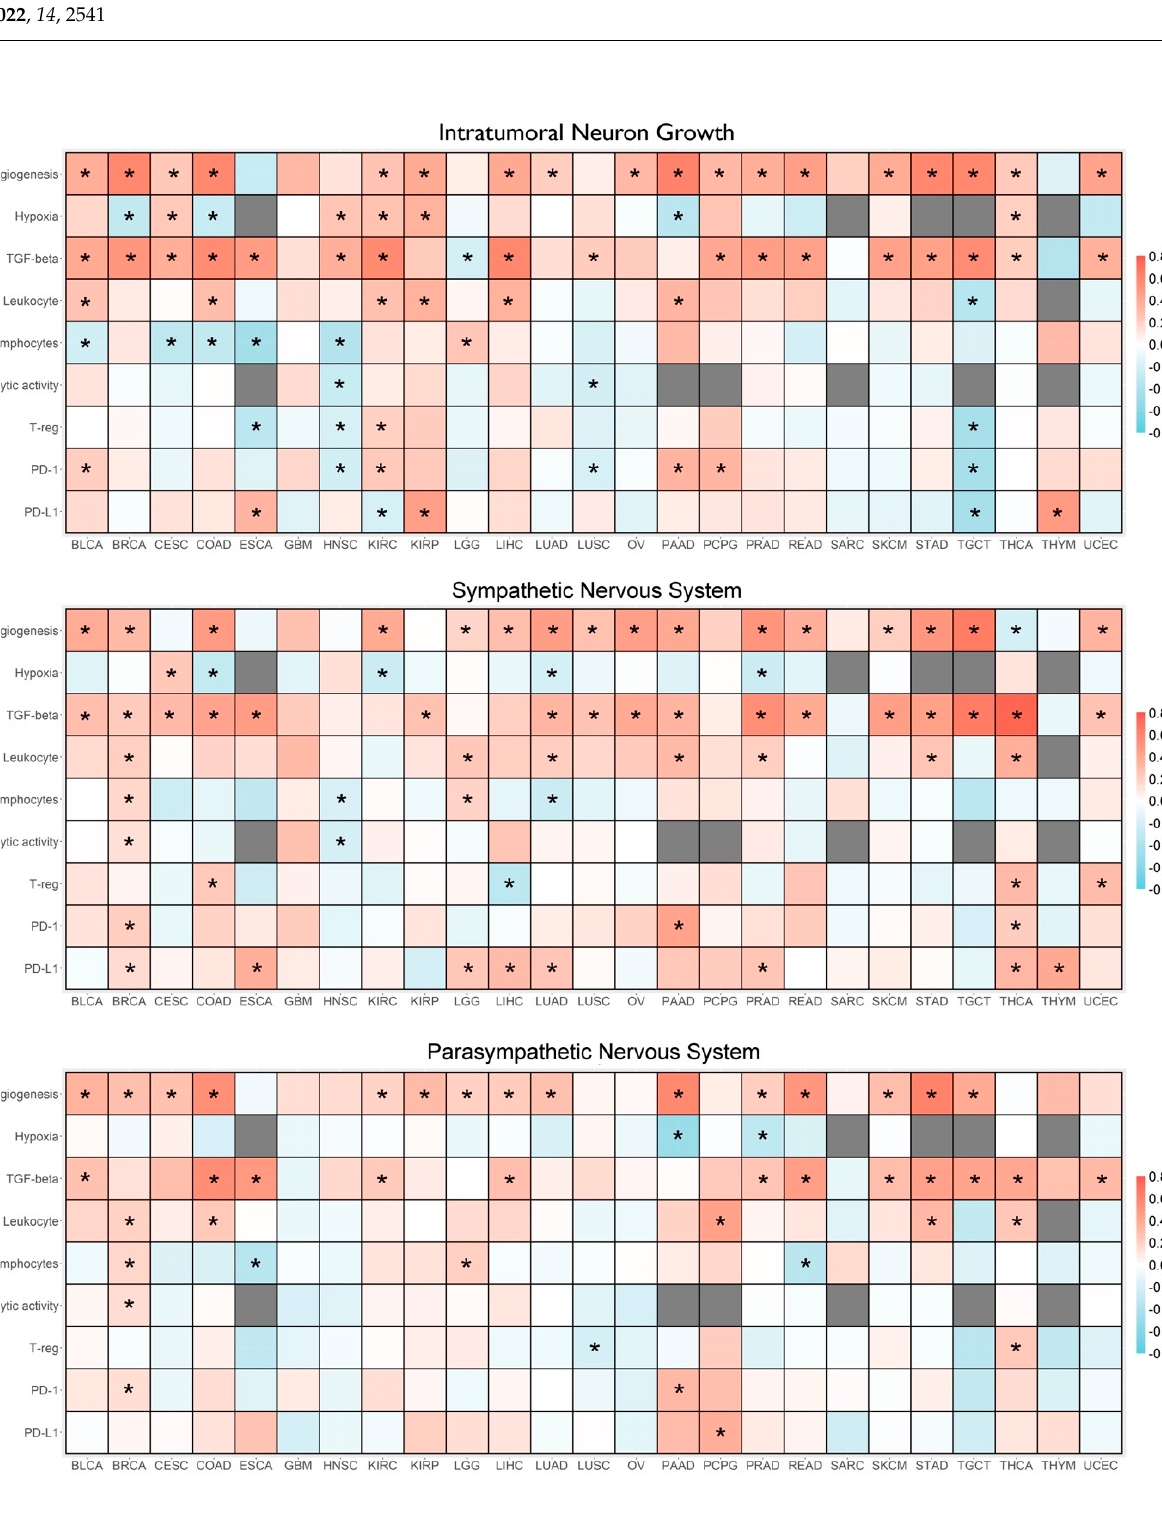
Figure 2. Correlations between autonomic nervous system gene expression signatures with tumor molecular and immunological characteristics. Asterisks indicate significant correlations after cor- recting for multiple comparison.